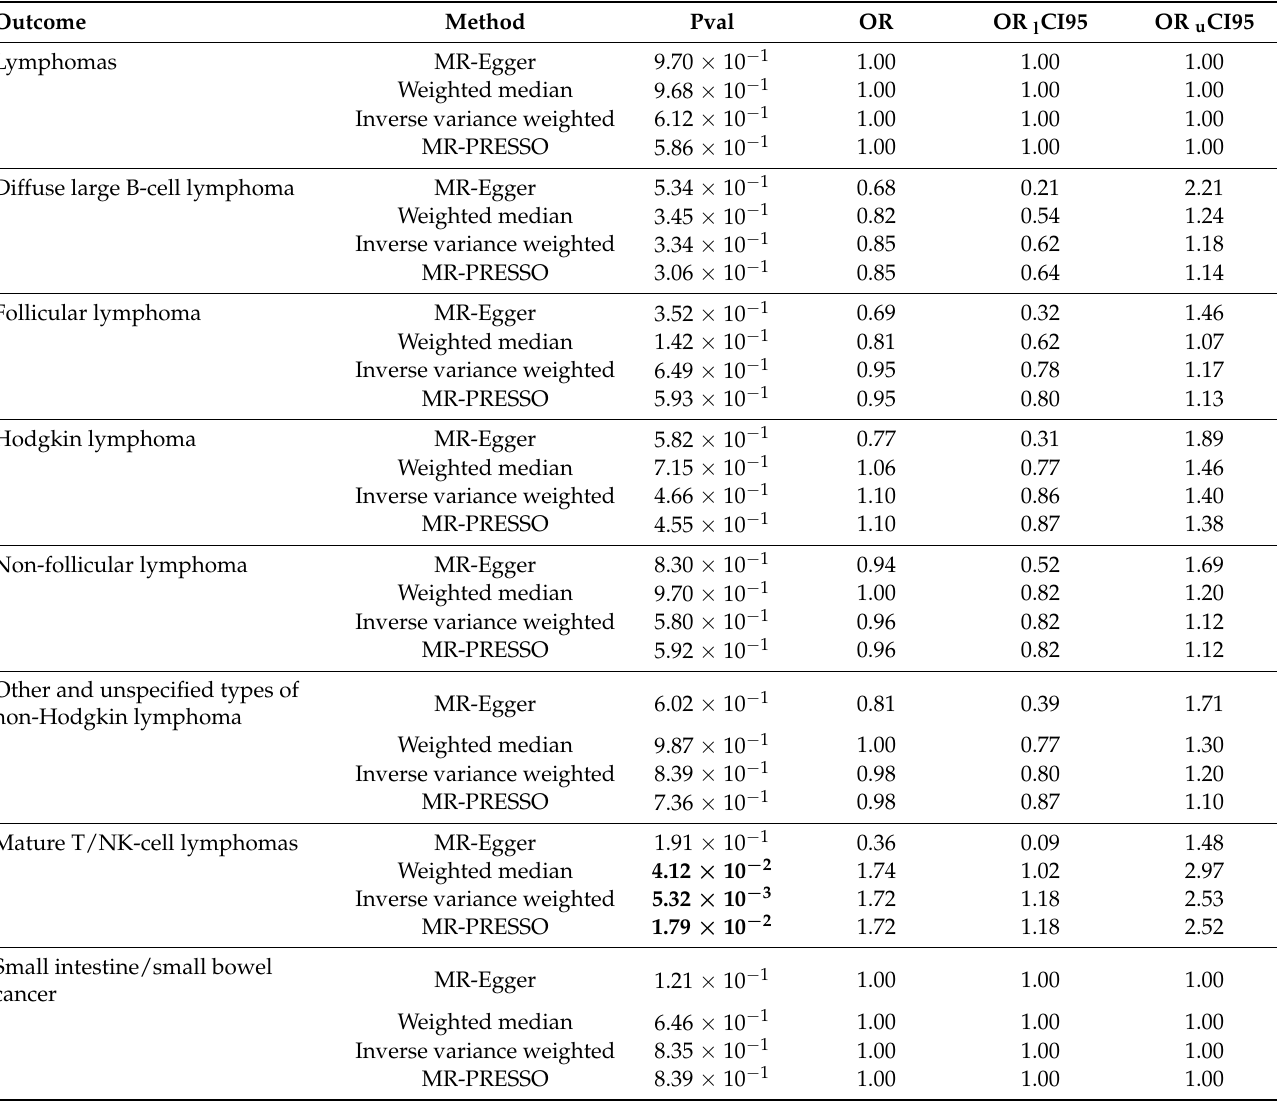
Table 2. 2SMR results under different methods where celiac disease is the exposure and different lymphoma subtypes are the outcome 10 × −